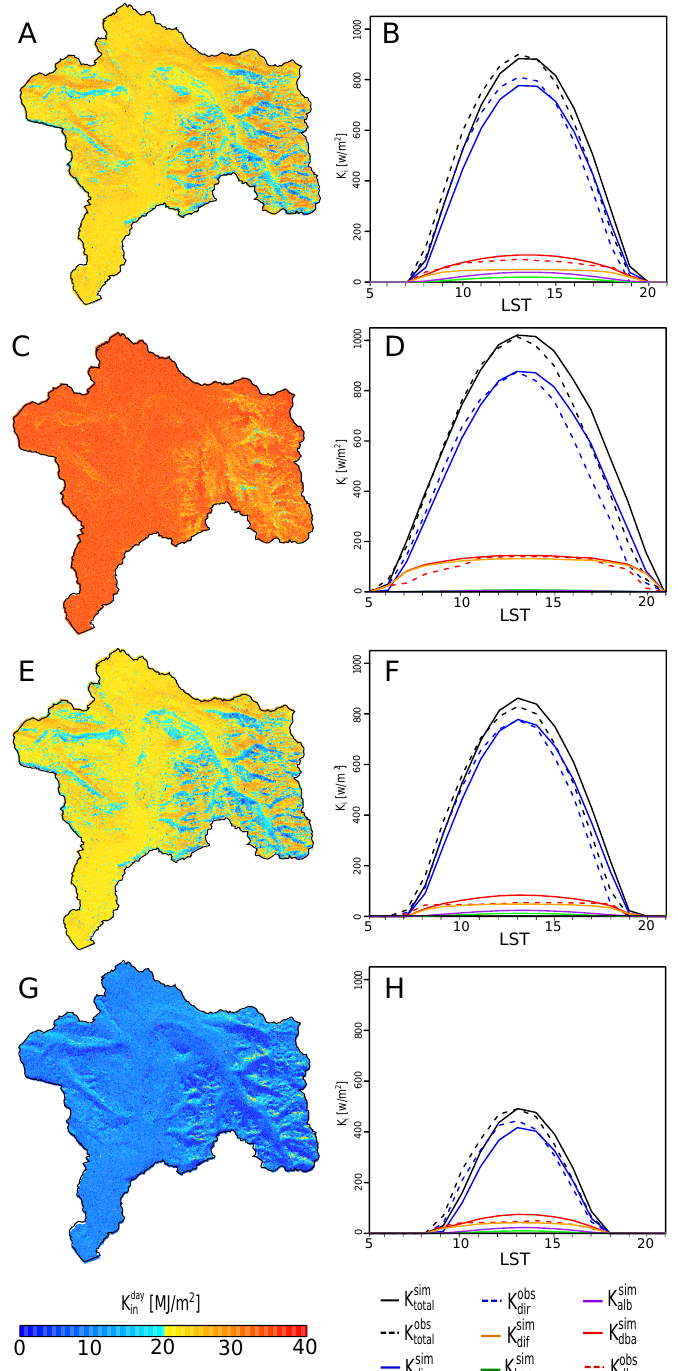
Figure 9. Spatial distribution of simulated cumulative daily incident radiation (MJ/m 2 ) and diurnal cycle of simulated and observed incident radiation flux (w/m 2 ) and its components in the upper Green River Basin during a typical, clear-sky day of: ( A , B ) spring equinox, ( C , D ) summer solstice, ( E , F ) autumn equinox, and ( G , H ) winter solstice. The super indices sim (solid lines) and obs (dashed lines) stand for simulated and observed values. K total , K dir , K dif , K bac and K alb represent the total downwelling, direct, diffuse, atmospheric backscattered and albedo-reflected radiation components. K dba = K dif + K bac + K alb